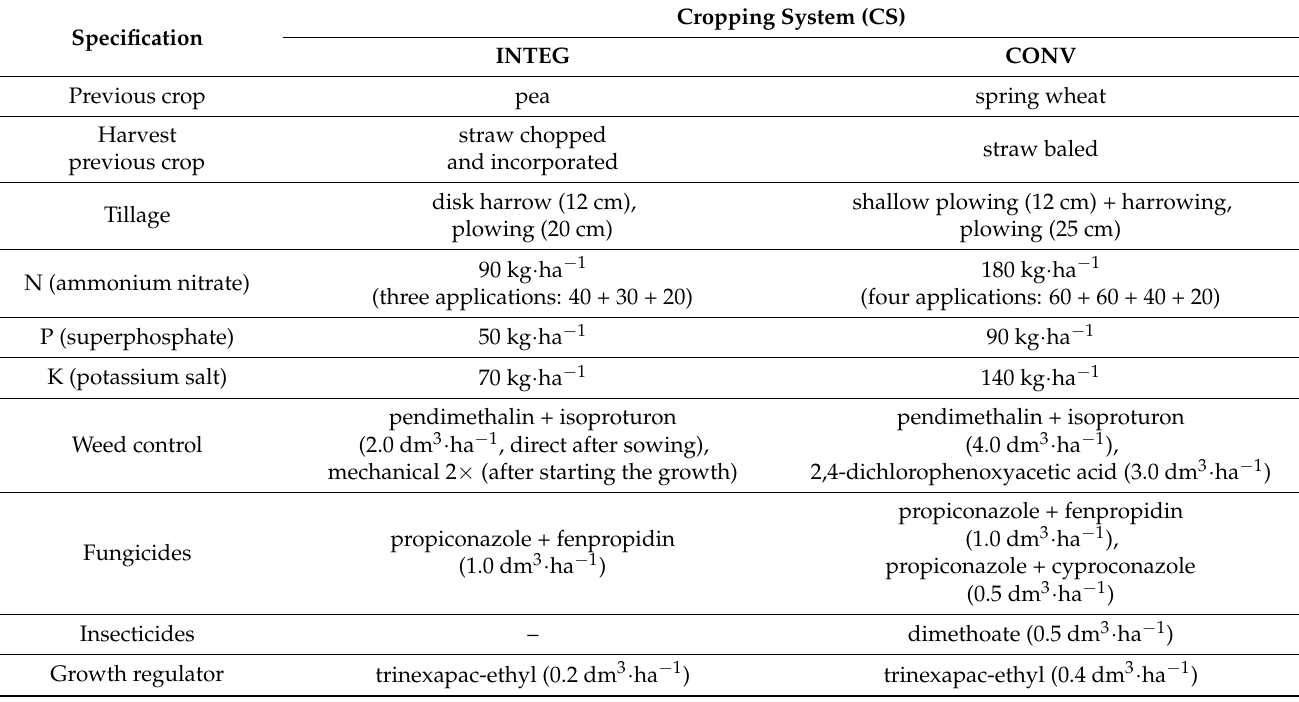
Table 1. Agricultural practices depending on experimental